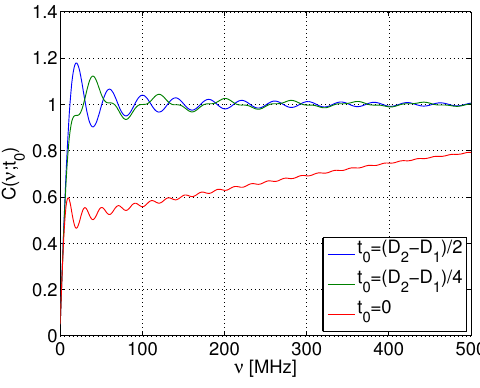
) : the integral of the point spread function (PSF). Figure 8. C ( ν ; t 0